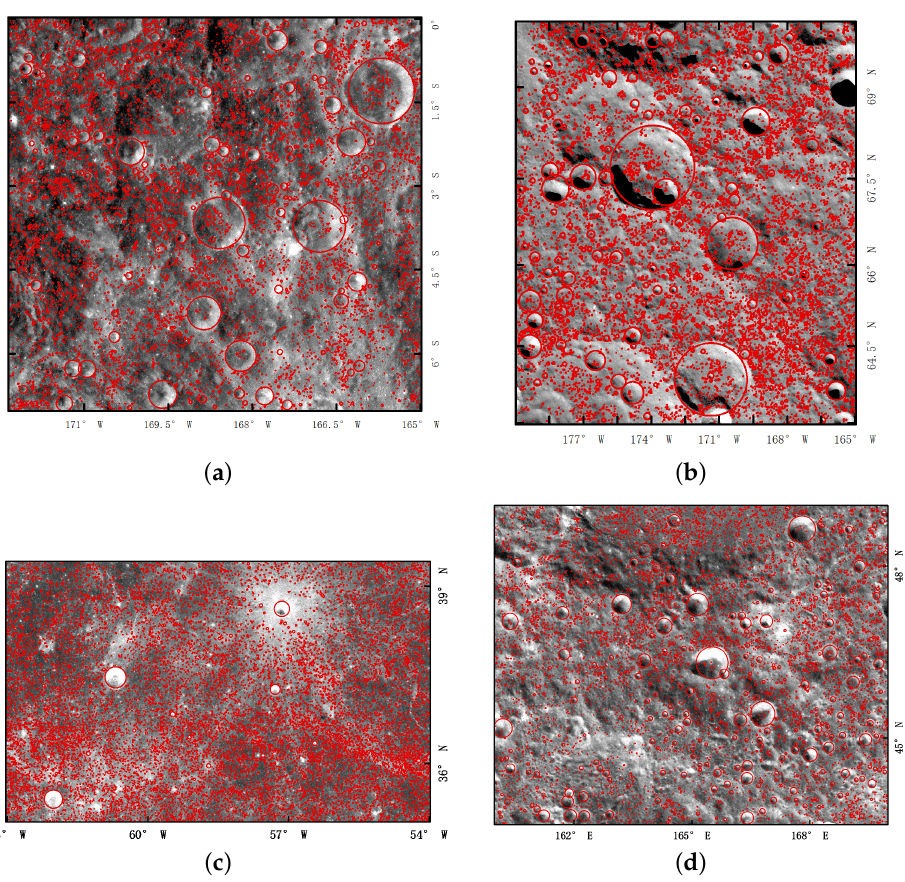
Figure 2. Labeled craters in four areas: ( a ) Equatorial area (R1), with 8632 craters; ( b ) high-latitude area (R2), with 8857 craters; ( c ) Maria area (R3), with 14,501 craters; and ( d ) Highland area (R4), with 6131